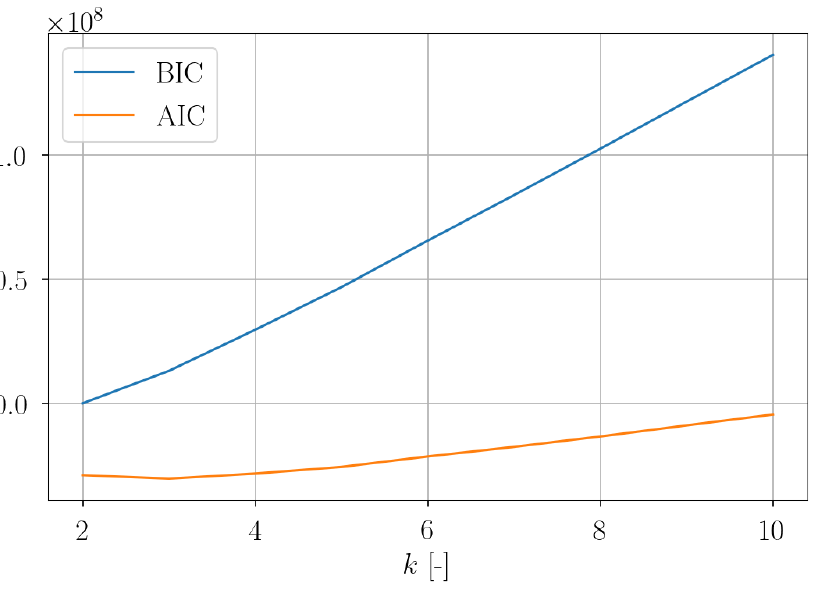
Figure 28. Akaike information criterion (AIC) and Bayesian information criterion (BIC) over k for setup